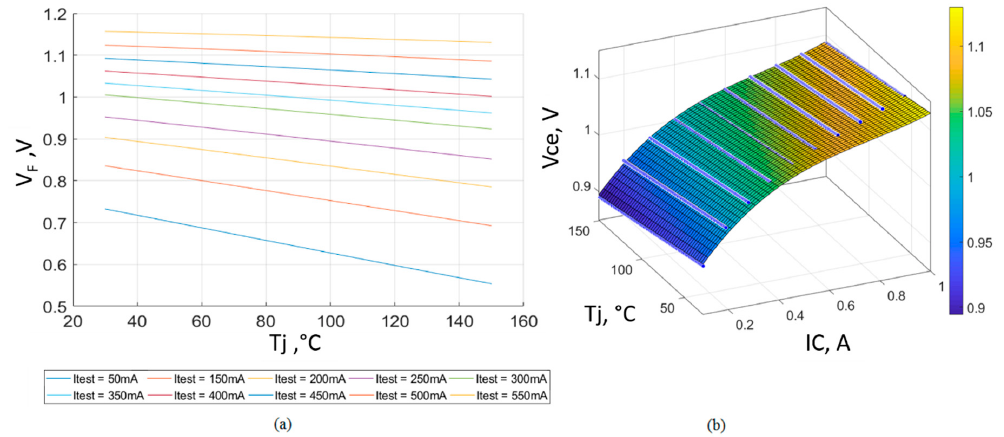
Figure 4. ( a ) Diode Temperature-Sensitive Electrical Parameters (TSEP), ( b ) IGBT TSEP.